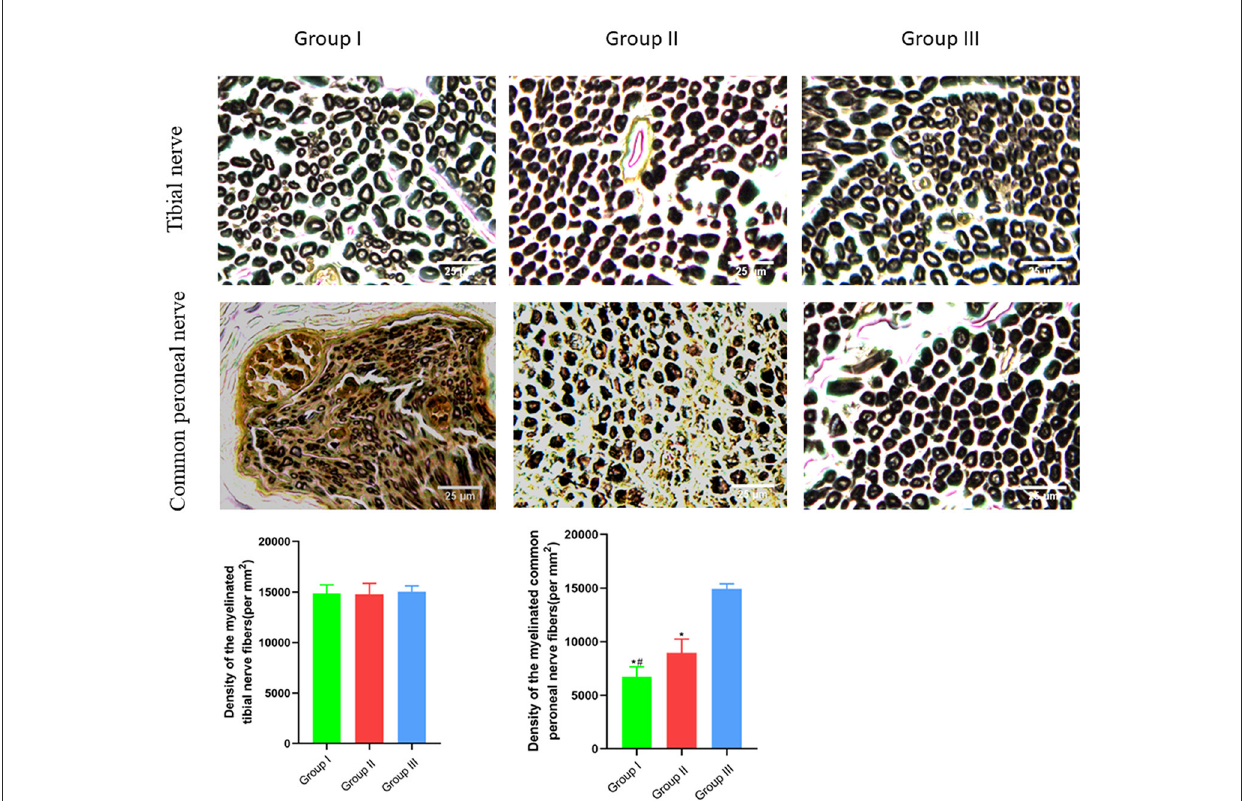
FIGURE5 Observation of myelinated tibial and common peroneal nerve fibers per unit area. Osmic acid staining, scale bar = 25 µ m. In Group I, only the distal end of the common peroneal nerve was sutured; in Group II, both proximal and distal ends of the common peroneal nerve were repaired; Group III was sham operated normal group. Data are expressed as mean ± SD ( n = 6 in Group I, 6 in Group II and 6 in Group III). * P < 0.05, vs. Group III; # P < 0.05, vs. Group II.